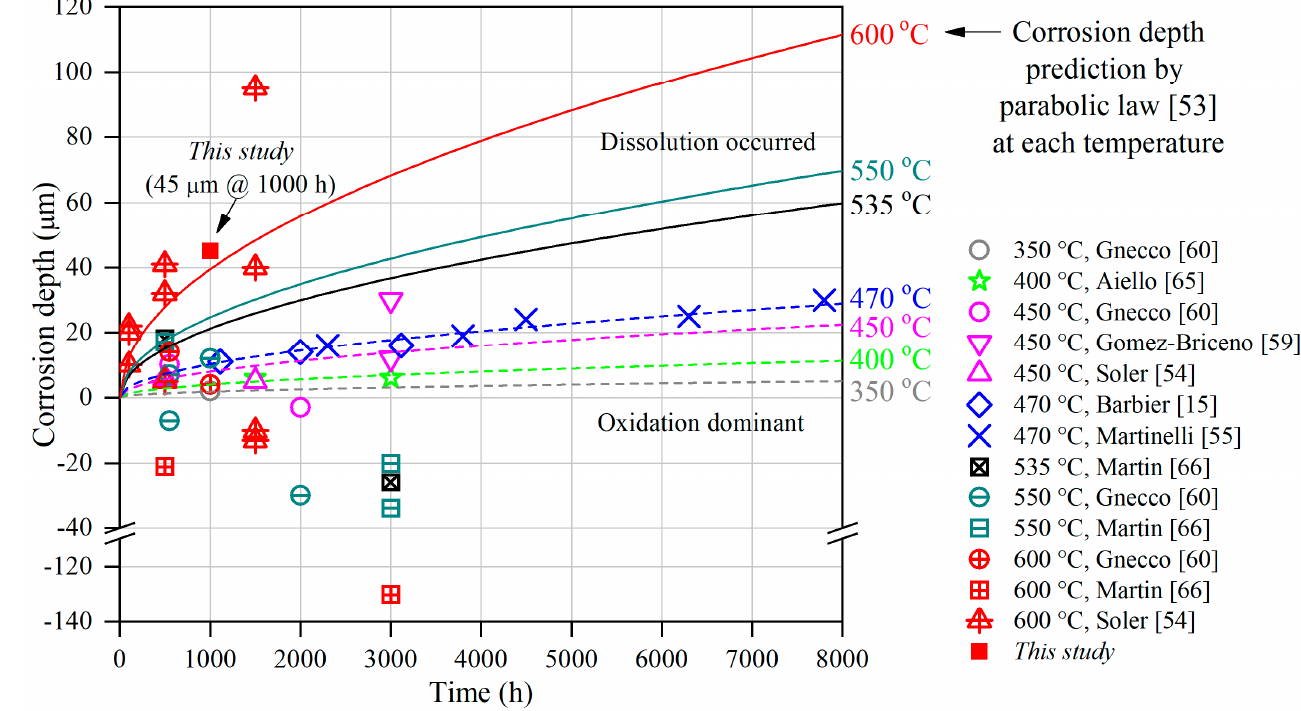
Figure 15. Prediction of the corrosion depths on T91 [15,53-55,59,60,65,66].